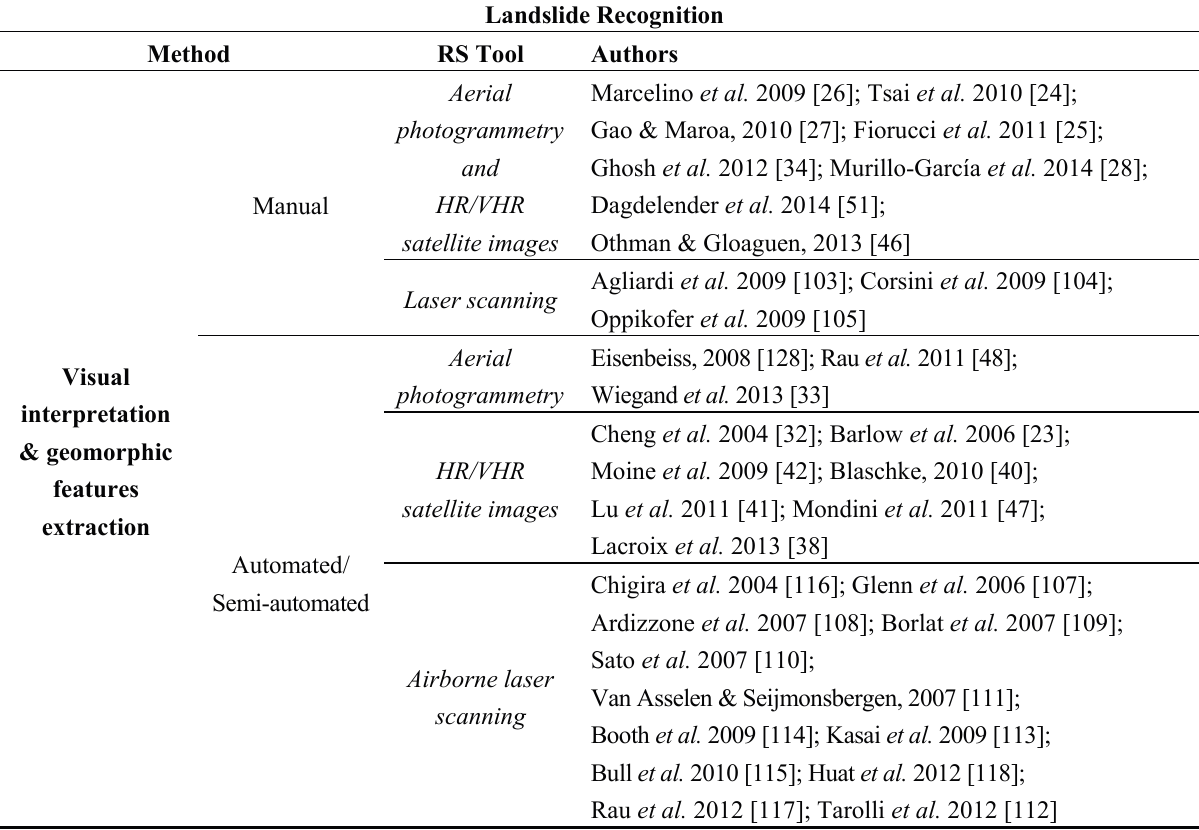
Table 1. Literature contributions to RS techniques applied to landslide